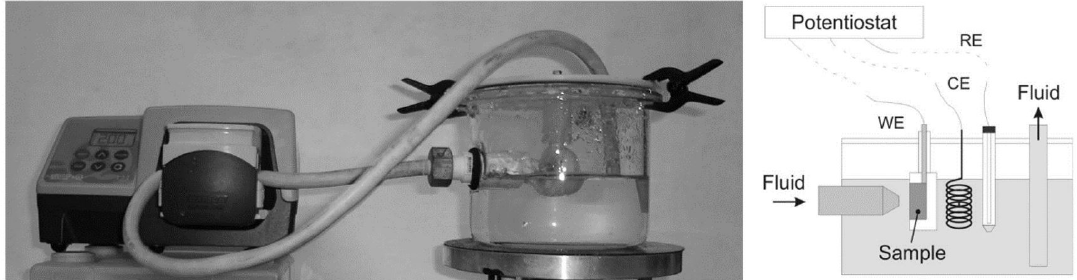
Figure 3. Experimental setup for liquid impingement and corrosion-erosion tests.